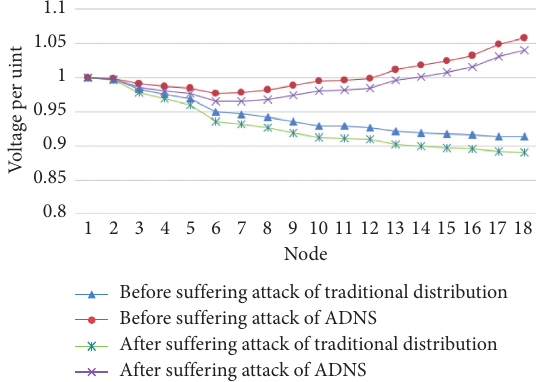
Figure 7: The voltage unit value of traditional ADN nodes before and after A I u